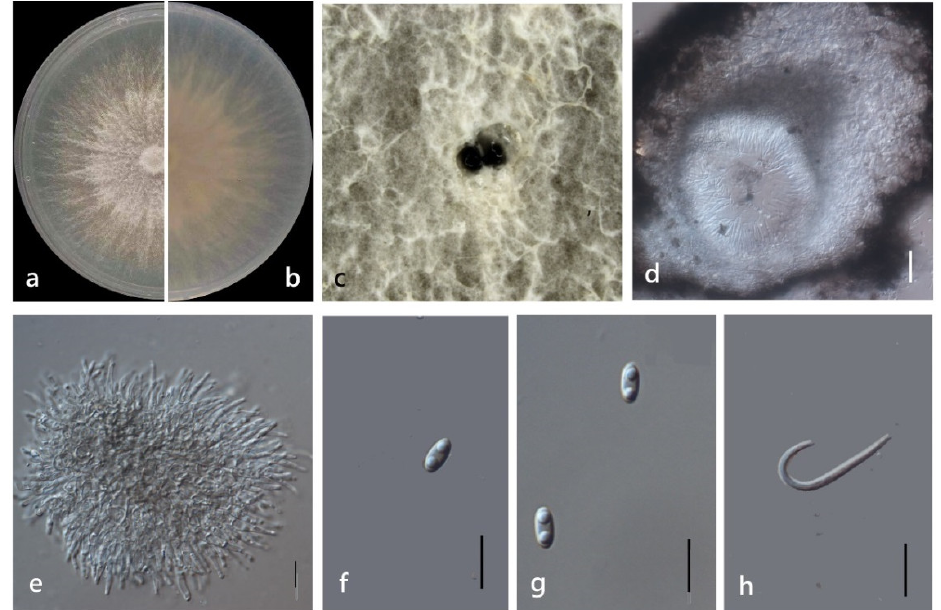
Figure 11. Diaporthe morindendophytica (ZHKUCC 22-0069) ( a ) Upper view of colonies on PDA; ( b ) Reverse view of colonies on PDA; ( c ) Pycnidia sporulating on PDA; ( d ) Section of